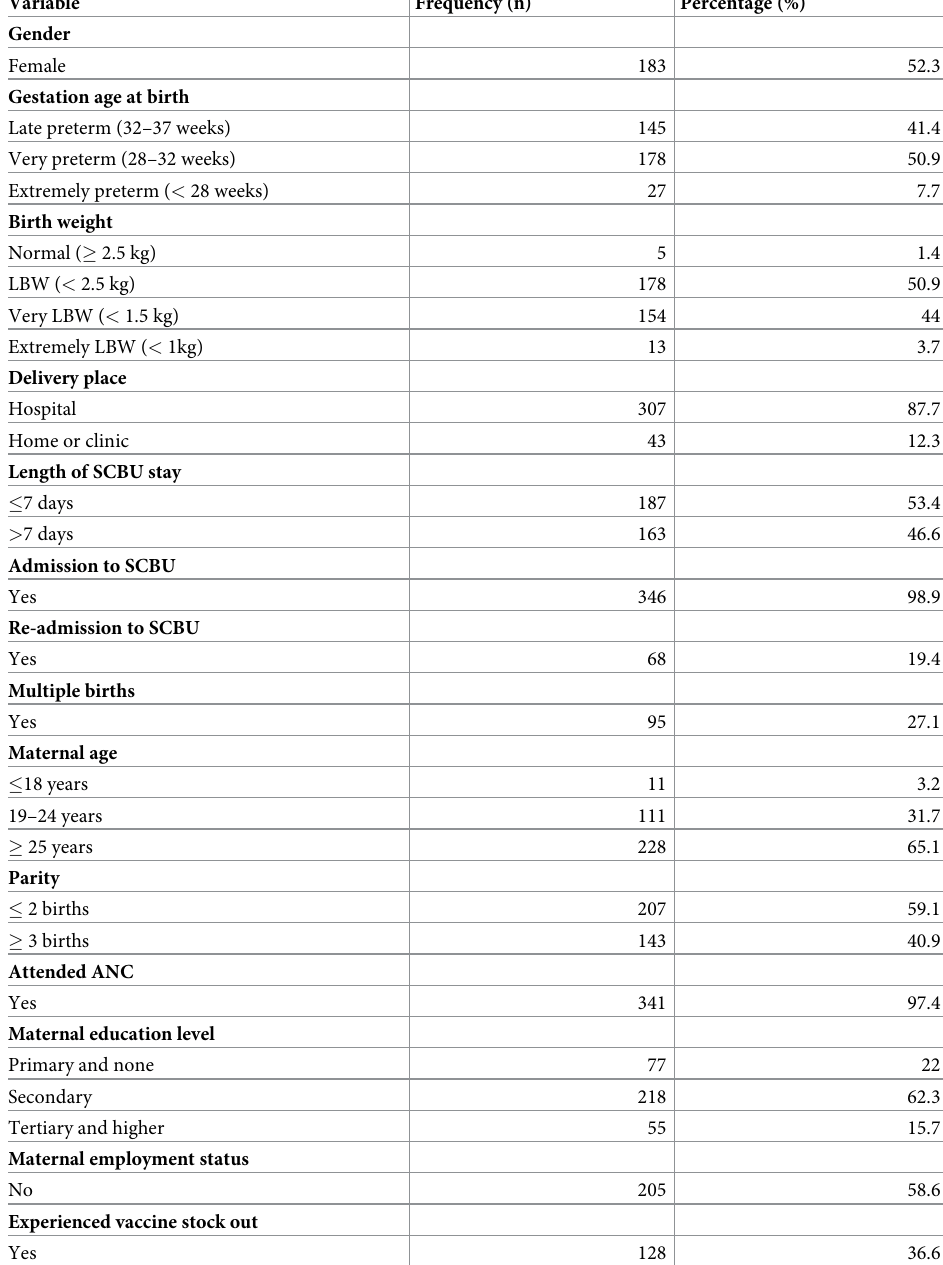
Table 2. Characteristics of preterm infants aged 6–24 months and their parents at Mulago Hospital, Kampala, Uganda (N = 350). Variable Frequency